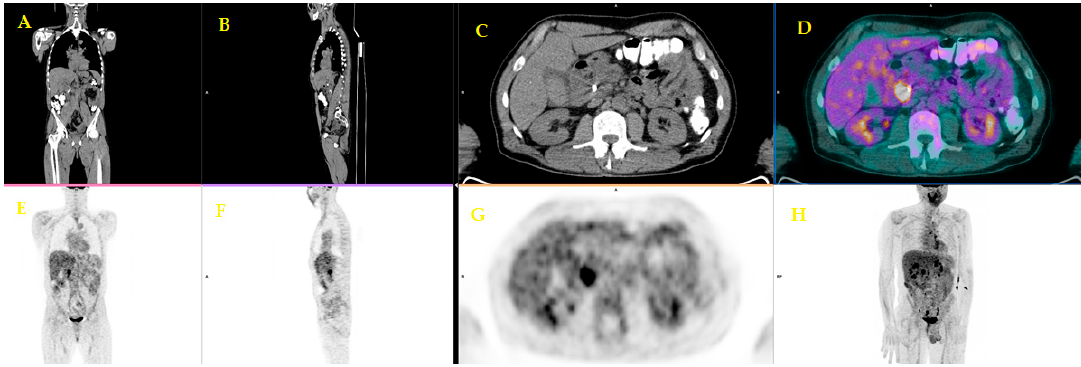
Figure 4. A fifty-six-year-old patient underwent staging FDG PET/CT with positive (ce)CT examination for local pancreatic lesion and equivocal for distant metastases. FDG PET/CT revealed a focal uptake on the head of the pancreas ( C , D , G ). (Images from Nuclear Medicine Unit, Padova University Hospital). Legend: A = Coronal image of low-dose CT; B = Sagittal image of low-dose CT; C = Axial image of low-dose CT; D = PET/CT fused image; E = Coronal image of PET; F = Sagittal image of PET; G = Axial image of PET; H = Maximum intensity Projection (MIP).